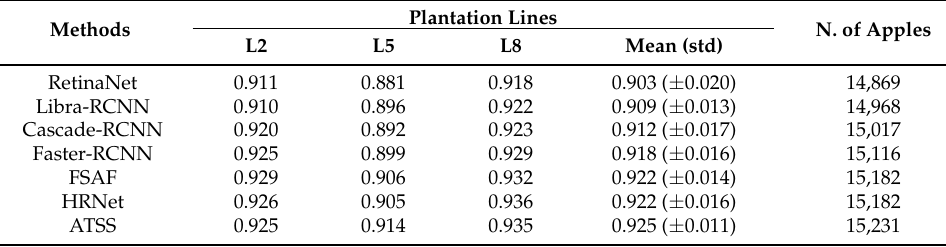
Table 4. Average precision (AP) of the apple detection methods in three plantation lines of the test